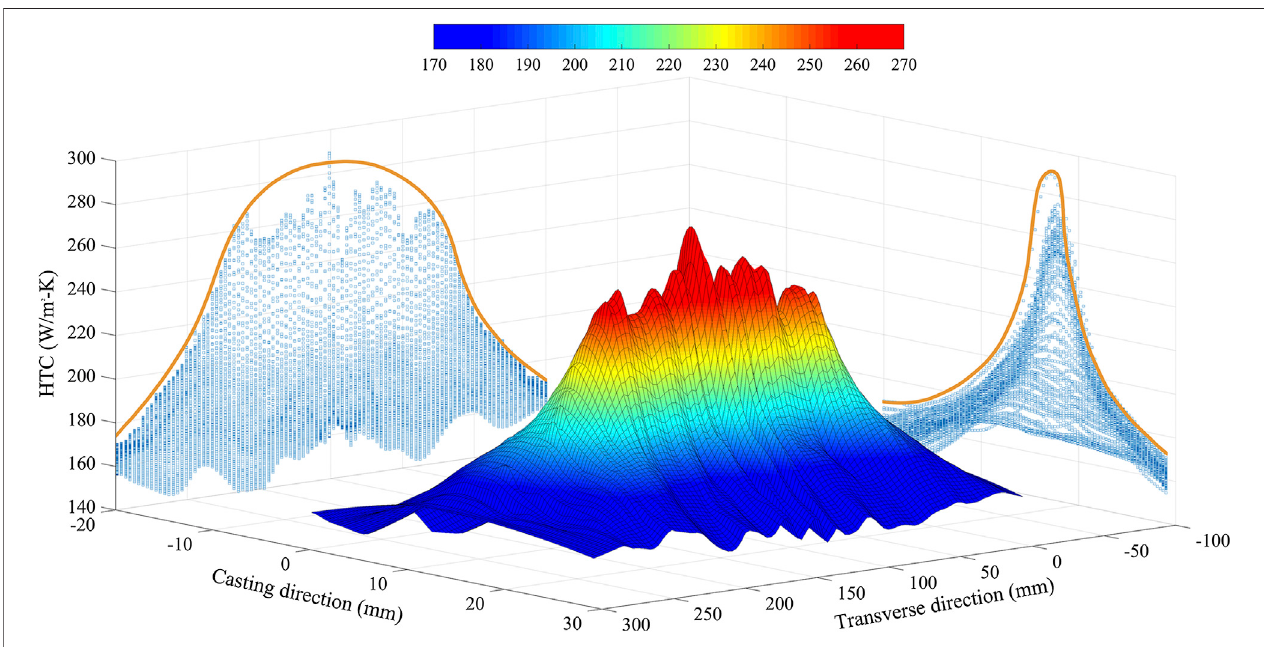
FIGURE 10 | Illustration of the two projected universal HTC